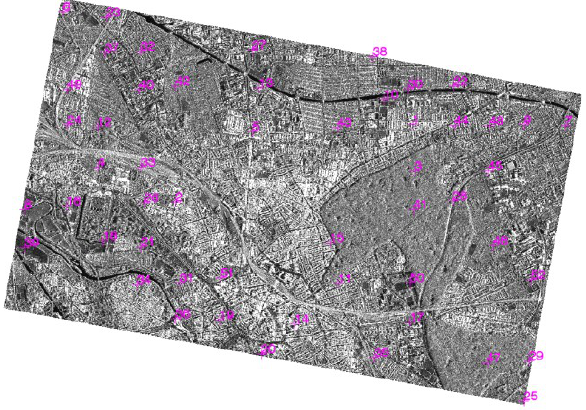
Figure 2. TerraSAR-X SpotLight image with automatically calculated tie points, Hannover. © CNES 2012, Distribution Astrium Services / Spot Image S.A., France, all rights